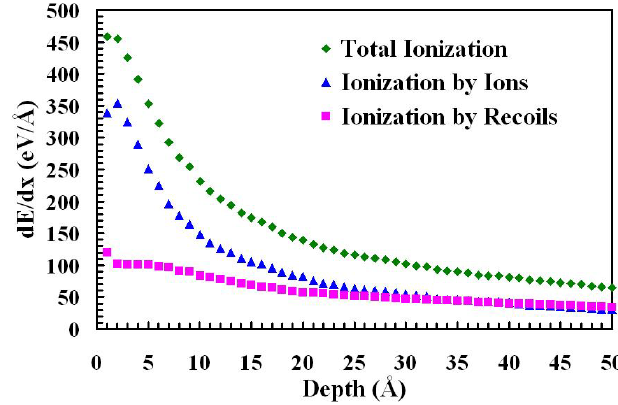
FIG. 2. (Color) Energy loss of 50 keV K (cid:1) ion at 82 degrees from normal to the target electrons by ions and